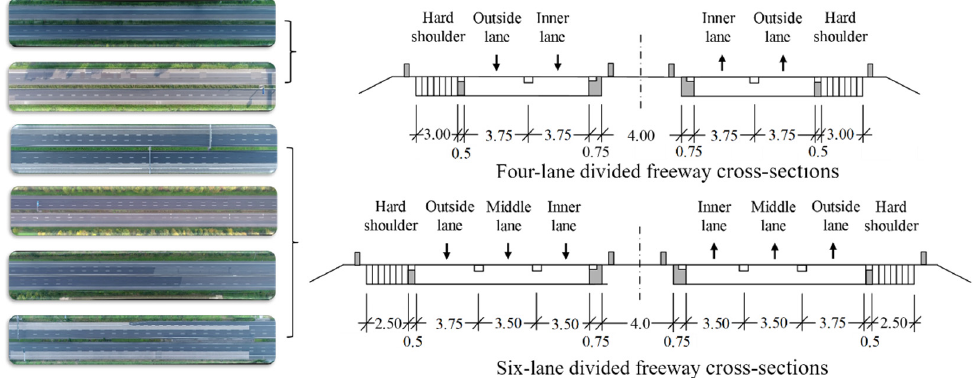
Figure 1. Illustration of the cross-section at the HighD dataset collection sites (unit: m).